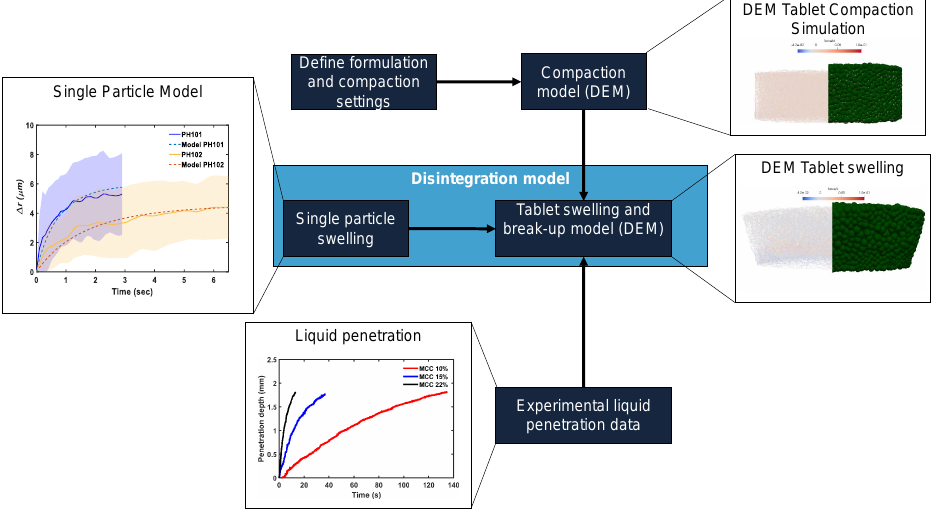
Figure 2. Work flow of the tablet swelling and break-up model. A single-particle model, DEM tablet and break-up process.